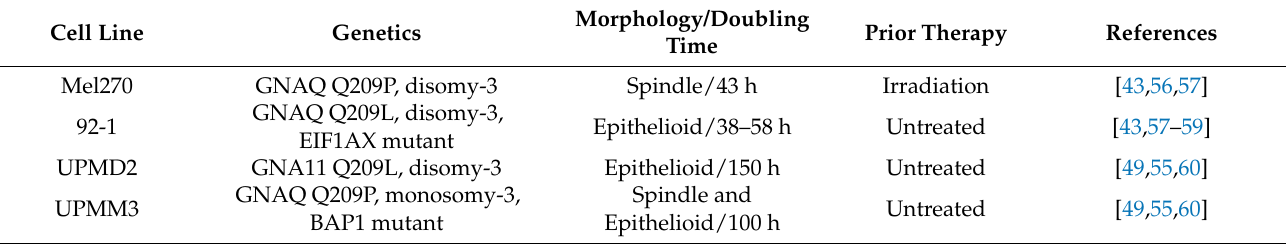
Table 1. Characteristic of uveal melanoma cell